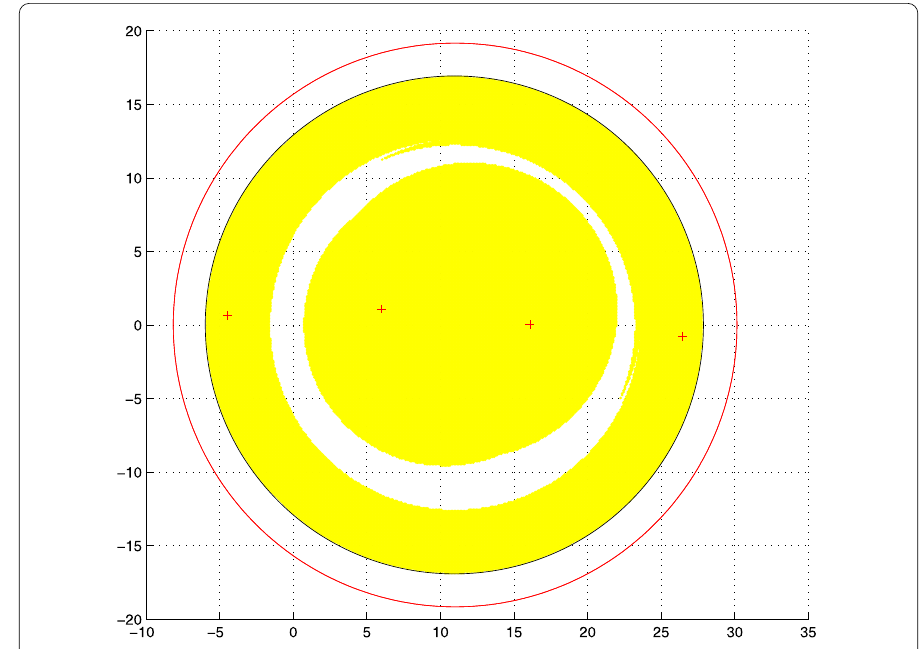
Figure 1 Comparisons of Ω ( A ), D ( A ) and Γ ( A )